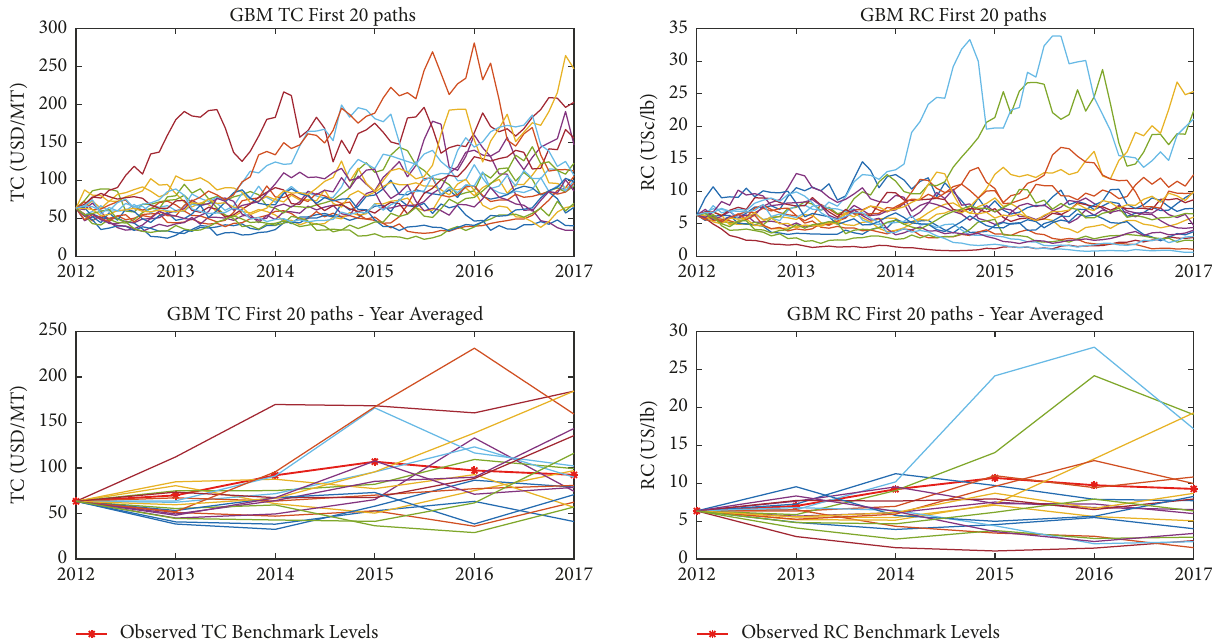
Figure 2: The upper illustrations show the first 20 Monte Carlo paths for either TC or RC levels using monthly steps. The illustrations below show the annual averages of monthly step forecasts for TC and RC levels.